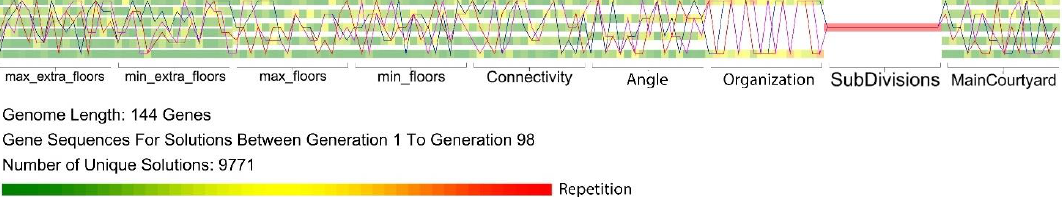
Figure 11. Geometric representation of each of the three selected phenotypes’ genomes. In the graph above, phenotypes are represented through the following polylines: Red — Phenotype 26, Blue — Phenotype 57, and Magenta — Phenotype 81. Table 2. The genomes of the phenotypes selected through the analysis of the relative difference rank (the body part of the phenotype onto which each gene sequence is applied to is presented in italics).